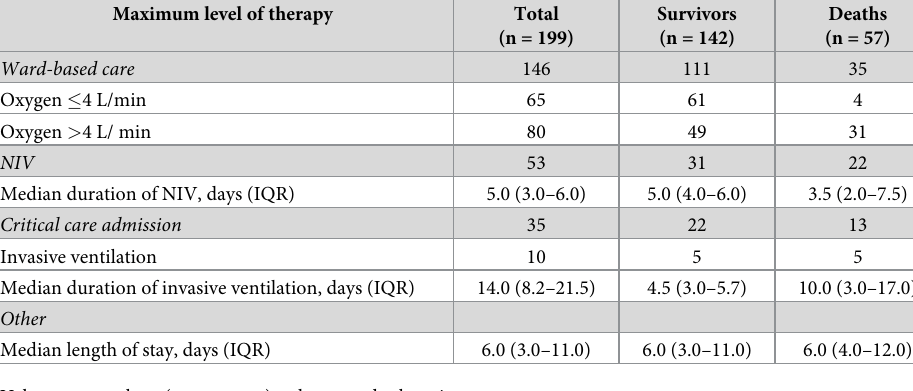
Table 2. Maximum level of oxygen therapy and